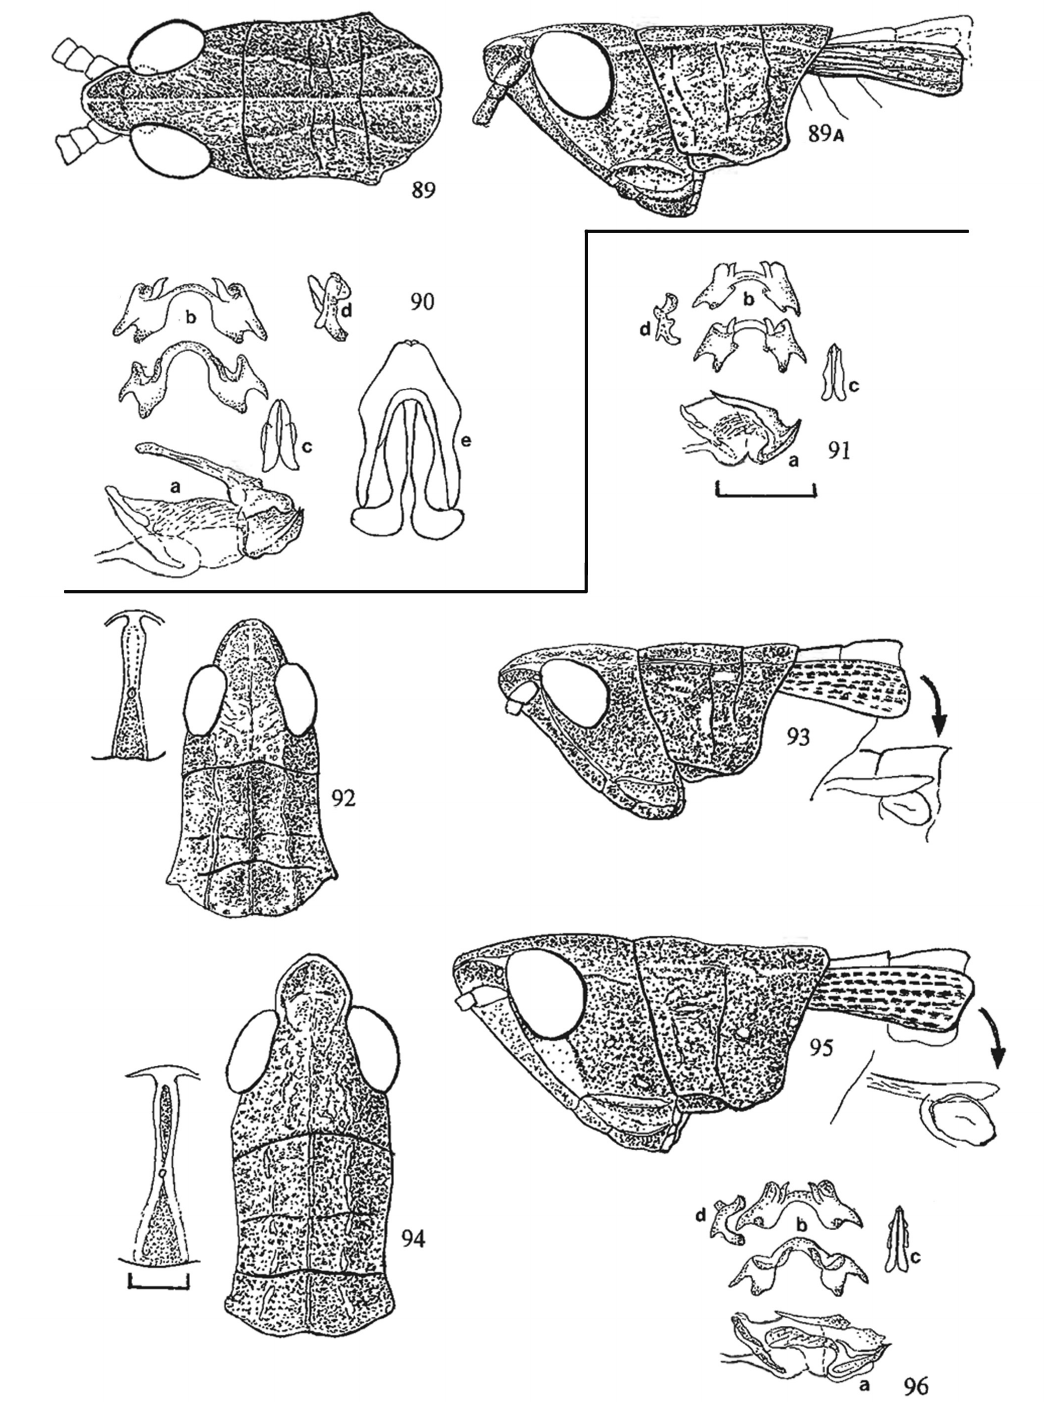
from right side; E. Phallic complex from dorsal aspect, epiphallus removed; Figs 91–93. A. neavei burtti : 91 . Male phallic morphology (explanation for lettering A–E. as for Fig. 90); 92. Dorsal aspect head and pronotum and frontal ridge; 93. Lateral aspect left side, head and pronotum; Figs 94–96. A. neavei neavei 94. Dorsal aspect head and pronotum and frontal ridge; 95. Lateral aspect left side, head and pronotum; 96 . Phallic morphology. All scale lines represent 1 mm: scale under Fig. 91 applies to Figs 90, 91, 96; scale under Fig. 94 applies to Figs 89–95, including frontal ridge and tympanic membranes. Arrowed insets to right of Figs 93 and 95 show size of hind- wings and tympana concealed by